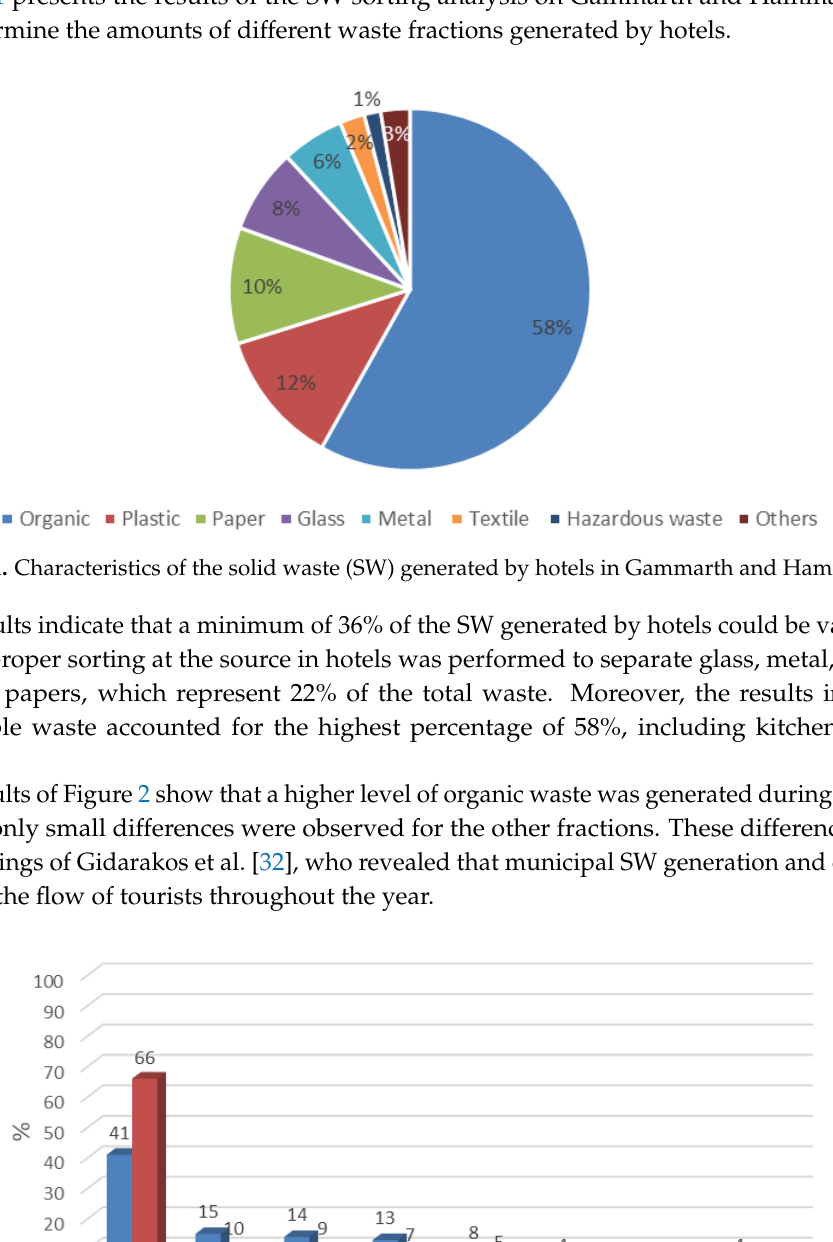
Figure 2. SW characteristics comparison in Gammarth between low and high seasons.